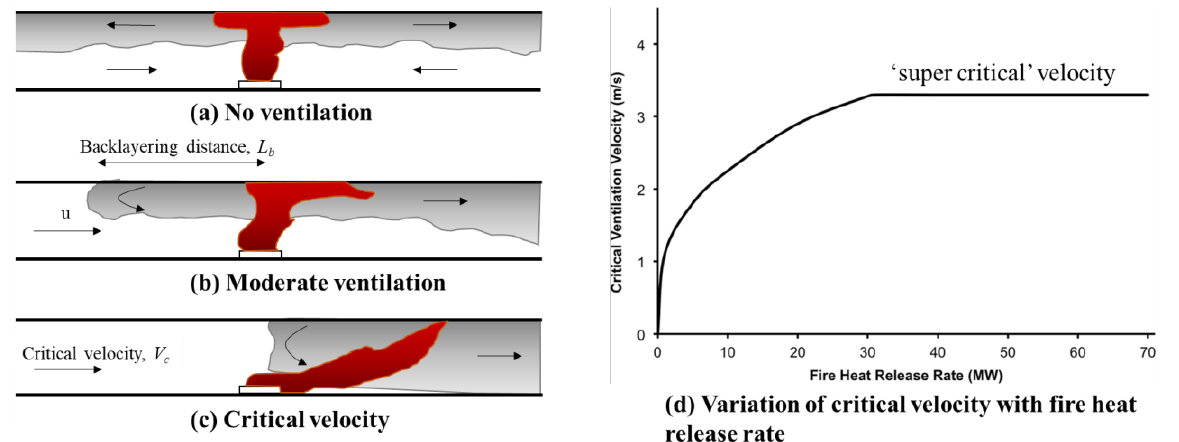
Figure 1. Illustration on ( a – c ) the concept of backlayering of smoke in a longitudinal tunnel and ( d ) critical velocity for different fire sizes.